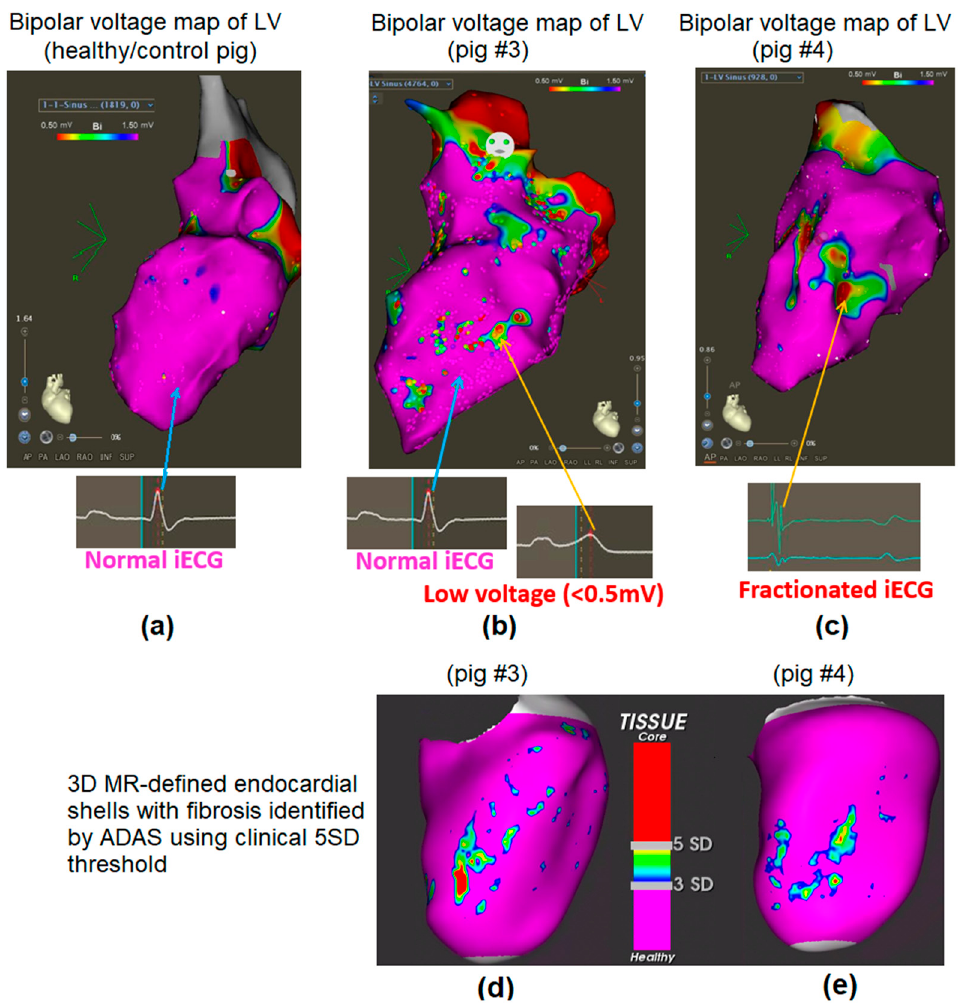
Figure 8. Examples of endocardial bipolar voltage maps, along with representative iEGM waves are presented for the healthy pig (a), pig #3 (b) and pig #4 (c). The location of low bipolar voltages in (b) and (c) agreed well with the with the corresponding location of LGE-defined fibrosis using the ADAS 3D software, as illustrated for pig #3 (d) and pig #4 (e). In both endocardial maps (i.e., from CARTO3 and segmented LGE shells), the fibrotic areas are indicated by red-green, while the healthy tissue is in magenta.